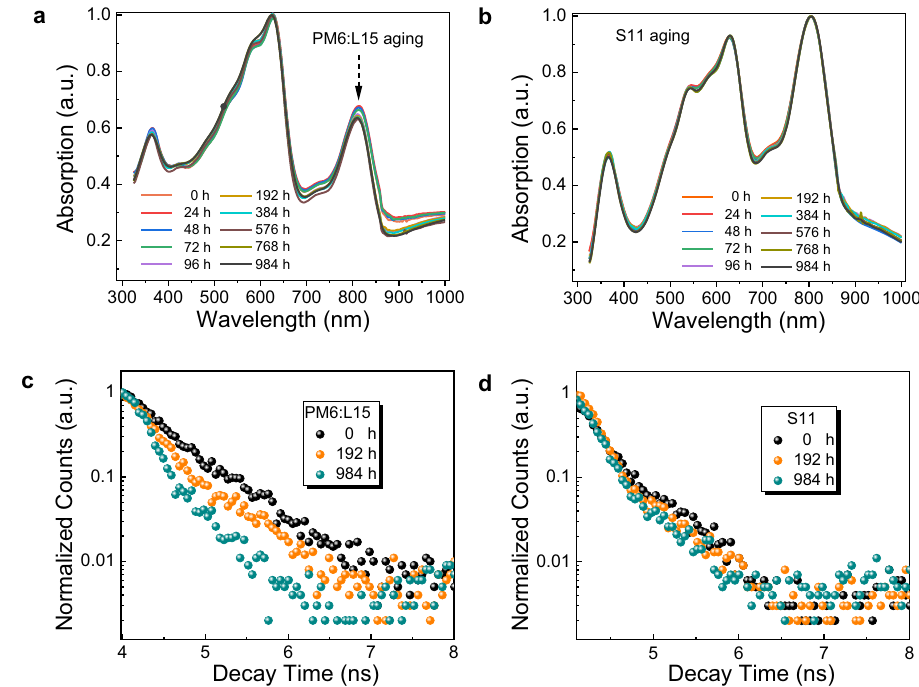
Fig. 5 | Absorption property and fl uorescence lifetime as a function of aging time. Normalized UV-vis absorption spectra of aged a two-component system PM6:L15 and b multicomponent system S11 fi lms with different heating duration.